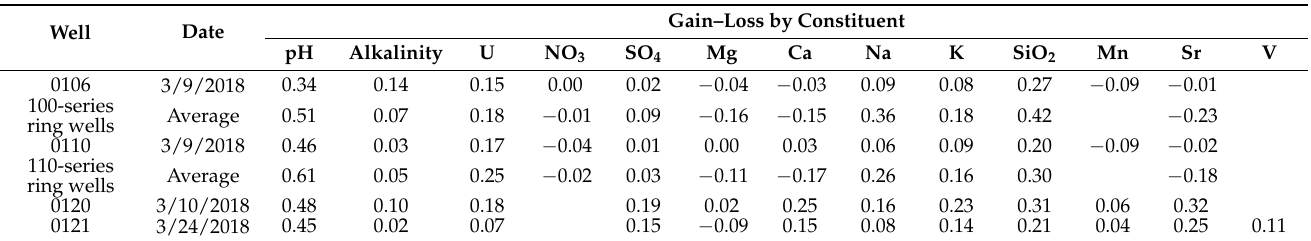
Table 3. Gain or Loss of Constituents to Groundwater During the Drift Phase of the PPTs Based on Chloride as a Conservative